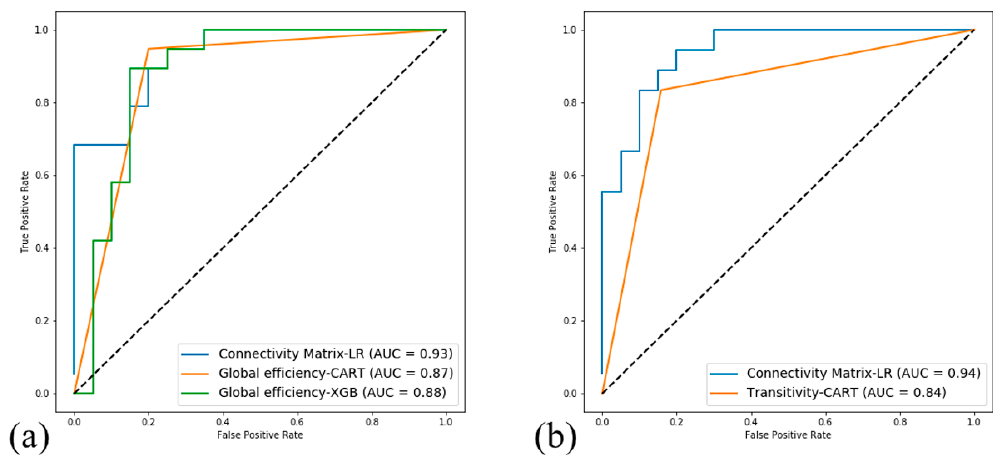
Figure 3. The receiver operating characteristic (ROC) curves and areas under the curves (AUCs) of the predictions. ( a ) Functional connectome analysis and topological coefficient analysis (AUC: connectivity matrix-LR = 0.93; global efficiency-CART = 0.87; global efficiency = 0.88); ( b ) structural connectome analysis and topological coefficient analysis (AUC: connectivity matrix-LR = 0.94; transitivity-CART = 0.84).